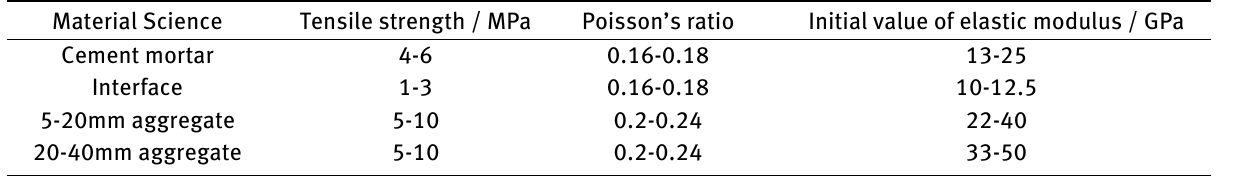
Table 2: Parameters of material micro components